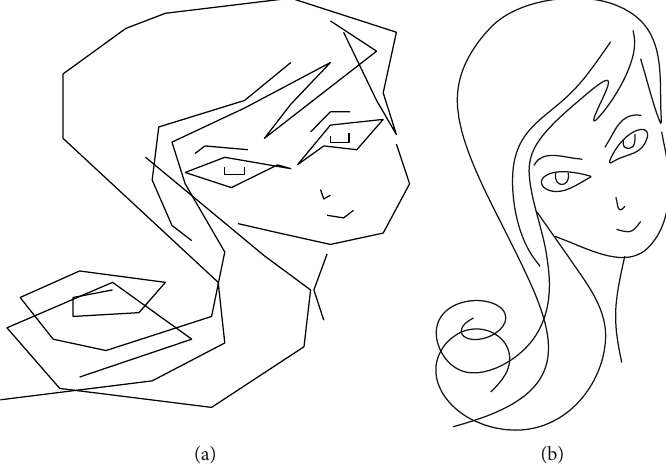
Figure 8: Application of R